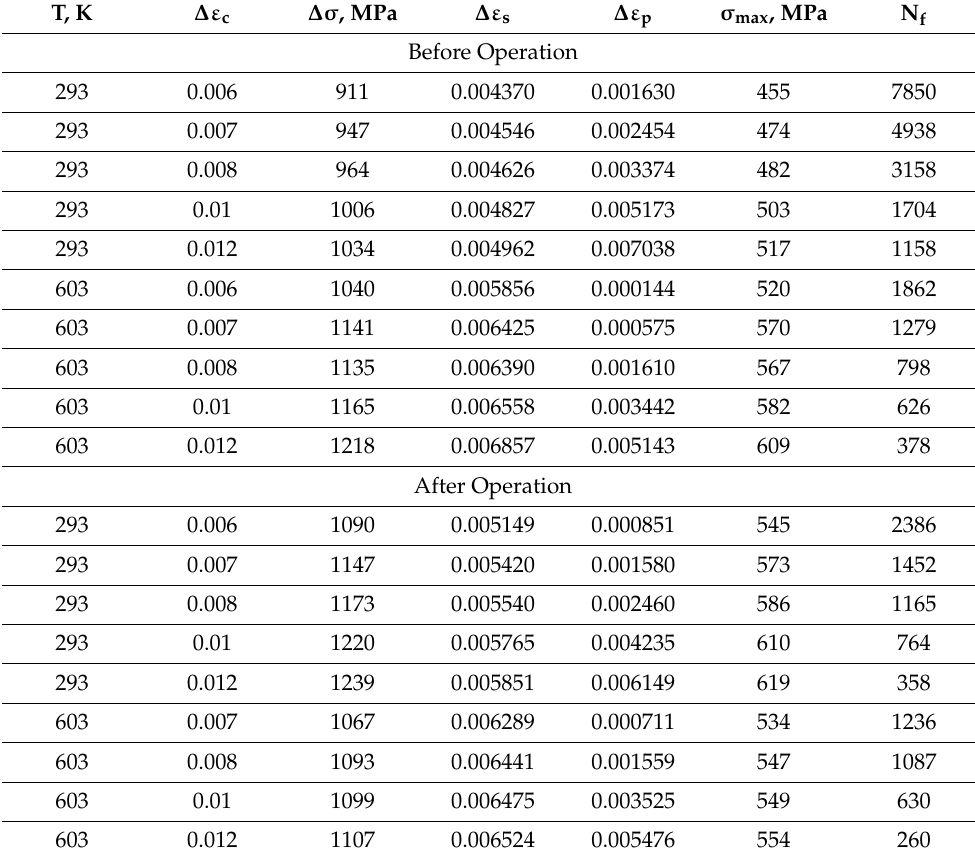
Table 1. Summary of the fatigue test